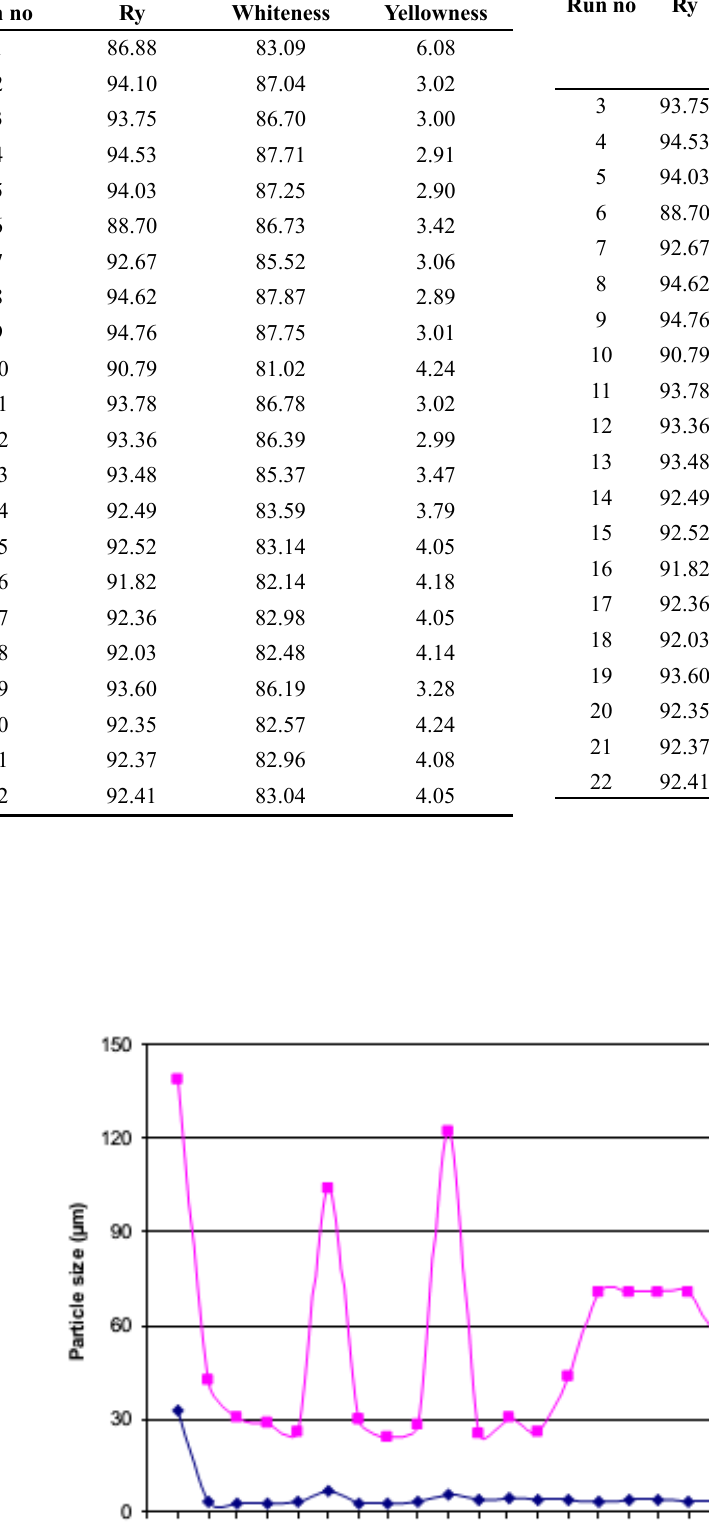
Table 7. ISO-5631 Ry-value of the products after milling with grinding aid Run no Ry ∆Ry Before and after milling with grinding aid